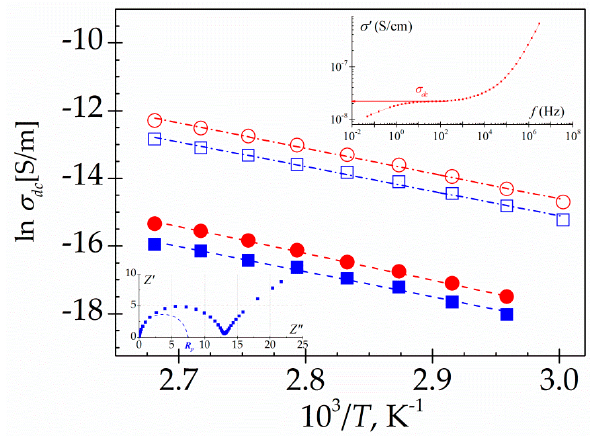
Figure 14. Temperature dependence of the dc conductivity (S/m) for PAzMa1 (full symbols) and PAzMa2 (open symbols) evaluated from the plateau at low temperatures of σ ’ versus f (circles) and from the Cole ‐ Cole impedance plots (squares).